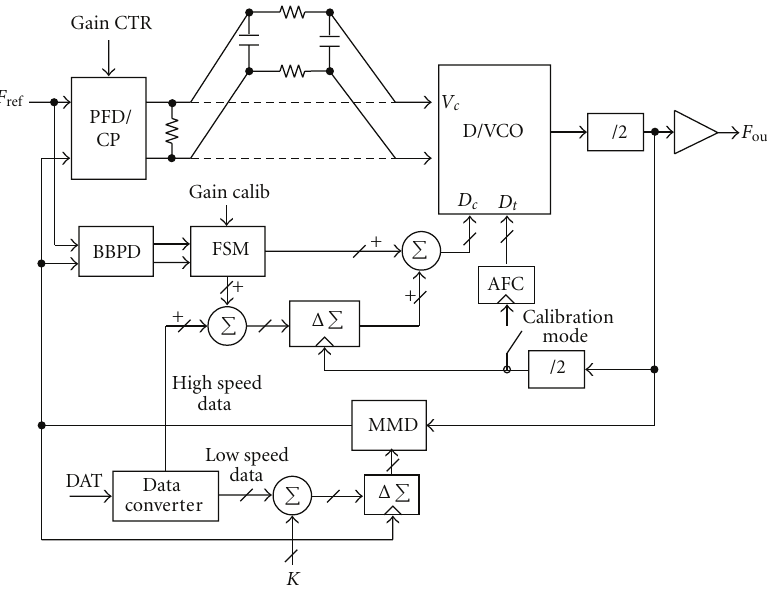
Figure 14: SDPLL with two-point modulation for RF transmitter systems.